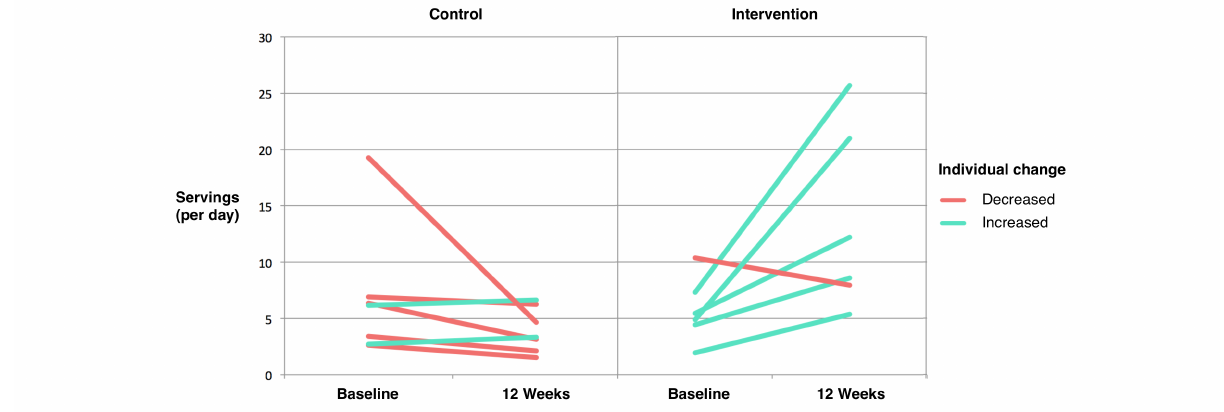
Figure 5. Individual changes in vegetable consumption, from baseline to 12 weeks after randomization (n=13). Vegetable consumption was self-reported using an adapted version of the validated semiquantitative Harvard Food Frequency Questionnaire. This analysis excludes 2 intervention and 2 control condition participants lost to